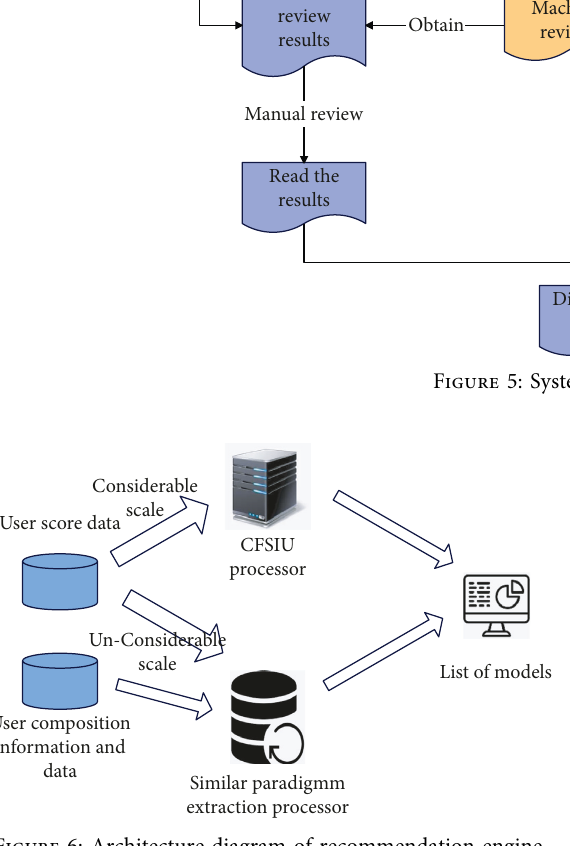
Figure 6: Architecture diagram of recommendation